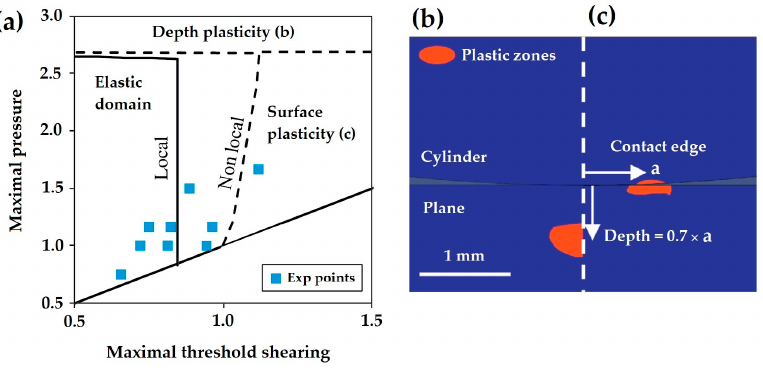
Figure 7. ( a ) Von Mises plastic boundary, ( b ) Depth and ( c ) Surface plasticity zones [61].